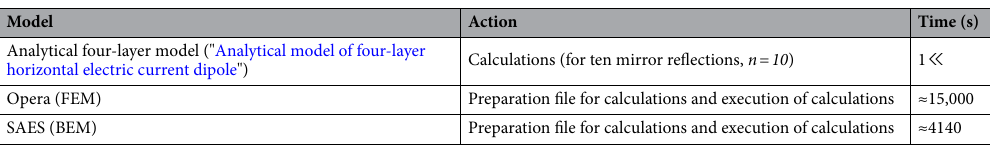
Table 1. Calculation time of the analytical model and numerical FEM and BEM models.